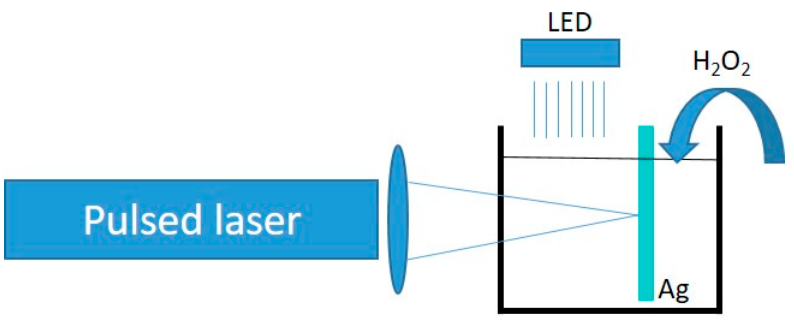
Figure 1. Schematic of the reaction setup, including a pulsed laser, a focusing lens, a reaction vessel containing a silver target, an illuminating LED, and a flow of H 2 O 2 .